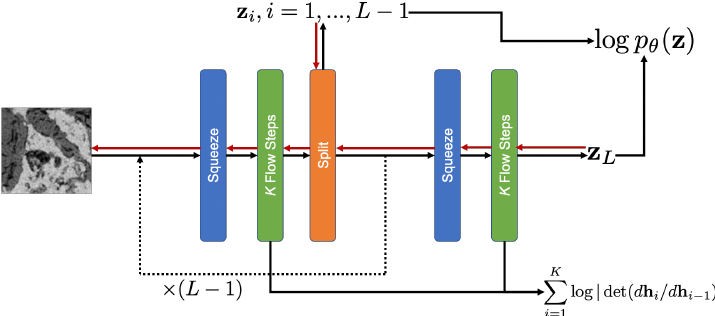
Figure 1. Glow model architecture adapted from [6]: during training (black arrows), the image is passed into the network, and successive flow steps transform the data into a vector z that follows a Gaussian distribution. During sampling (red arrows), vectors z i are sampled from p θ ( z ) and fed into the reversed